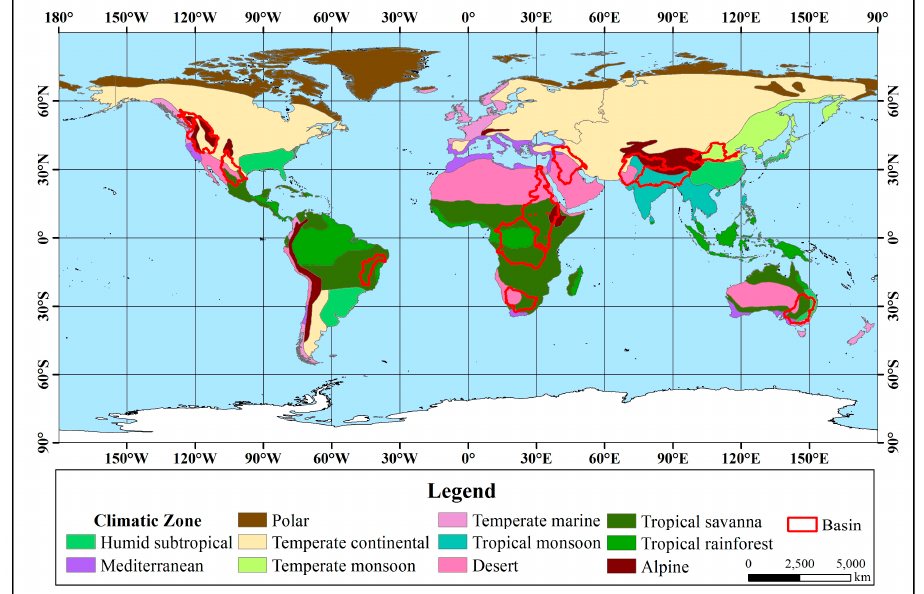
Figure 6. Distribution with an insignificant downward trend in river discharge.